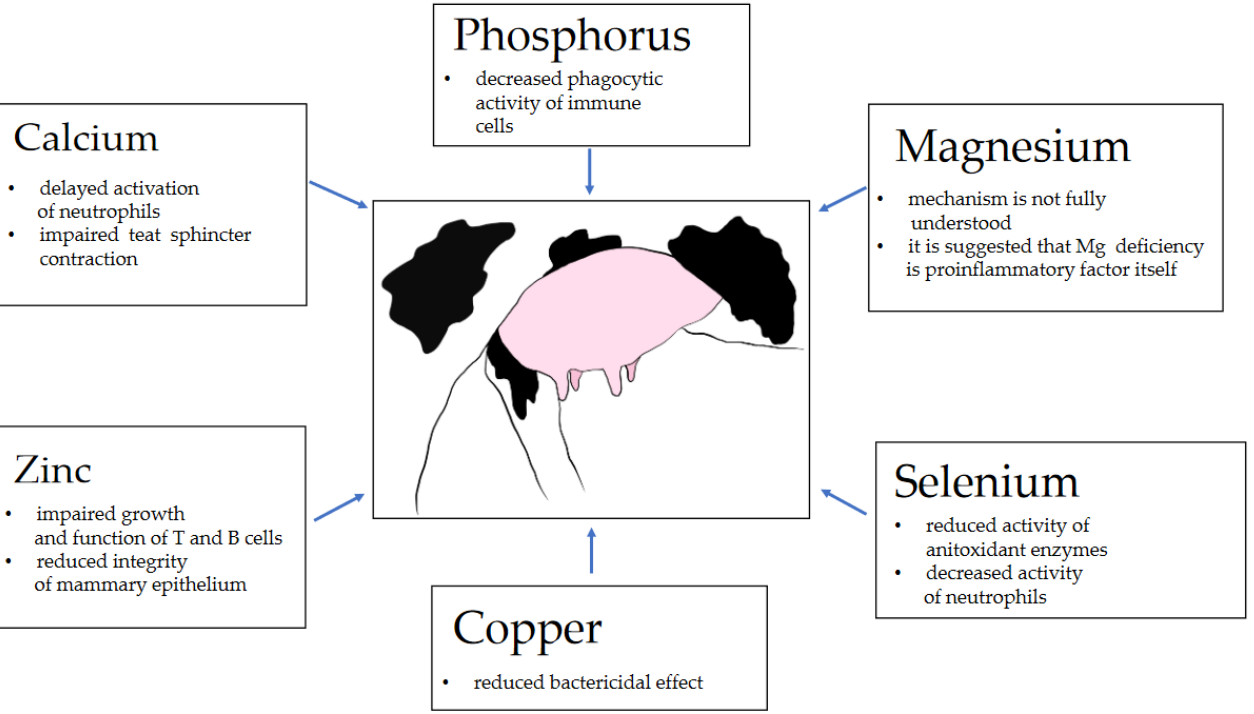
Figure 1. Brief summary of pathomechanisms related to mineral deficiencies and mastitis incidence.